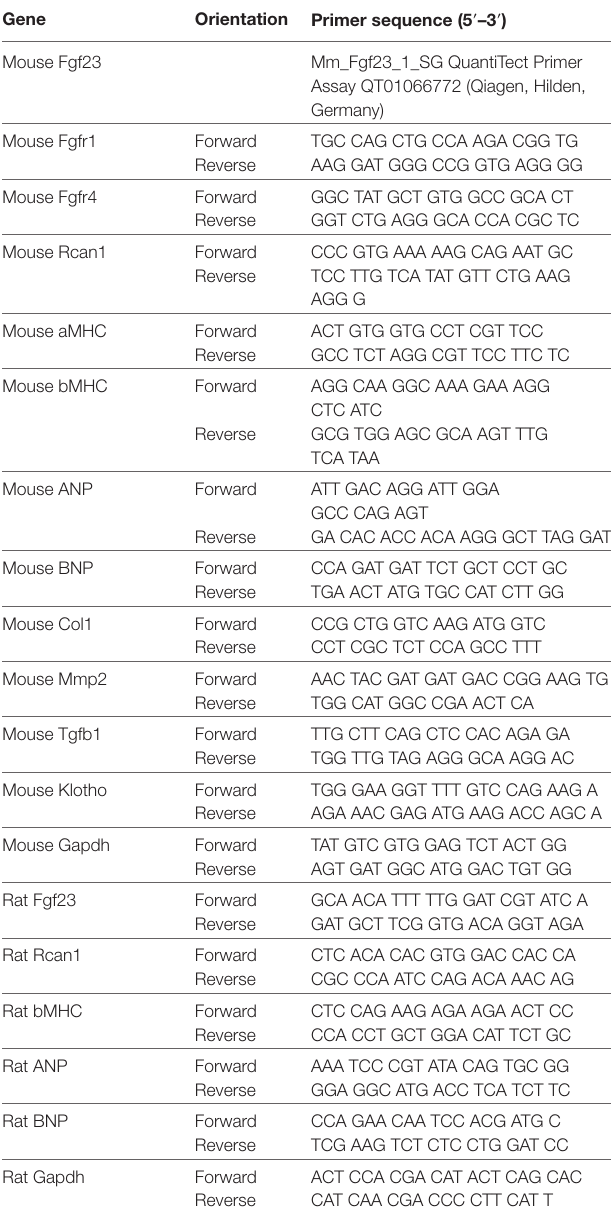
Table 1 | The following oligonucleotides shown in 5 ′ –3 ′ orientation were used as primers for quantitative RT-PCR analyses. gene Orientation Primer sequence (5 ′ –3 ′